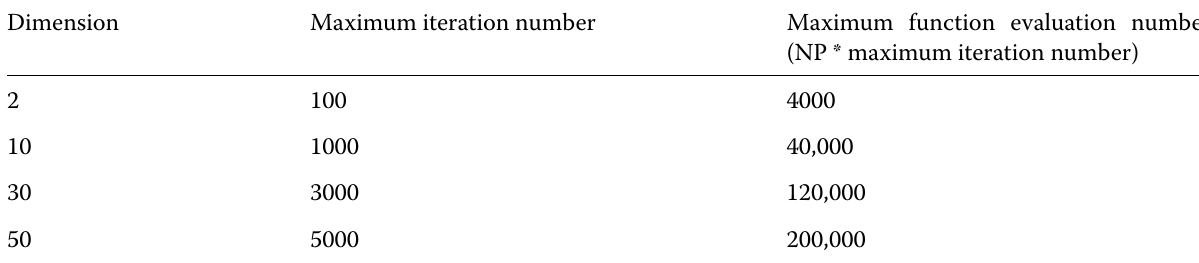
Table 2 Corresponding experimental settings Dimension